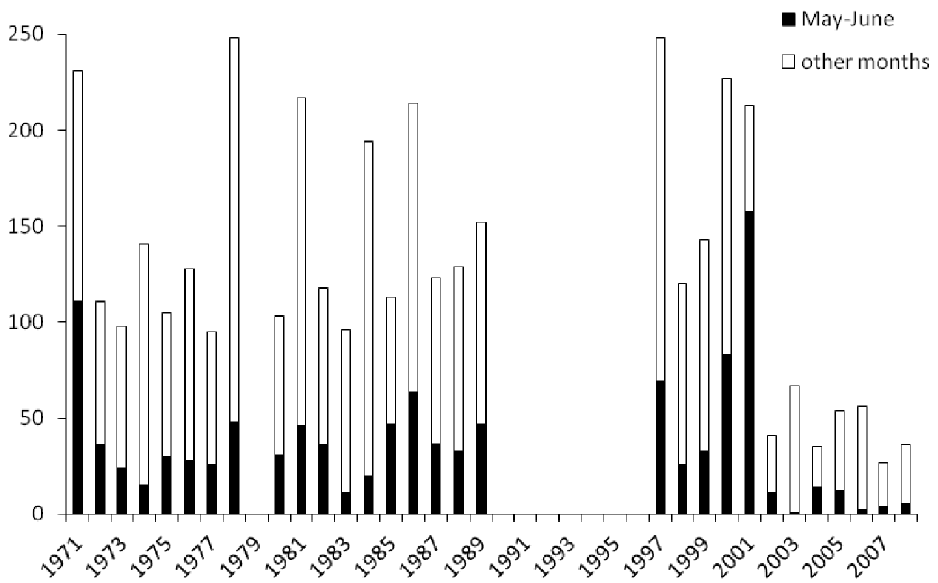
Figure 1. Time series histogram for annual Caspian seal mortality 1971–2008, along the 10 km Apsheron monitoring zone (40.523 N, 50.119 E and 40.501 N, 50.226 E).